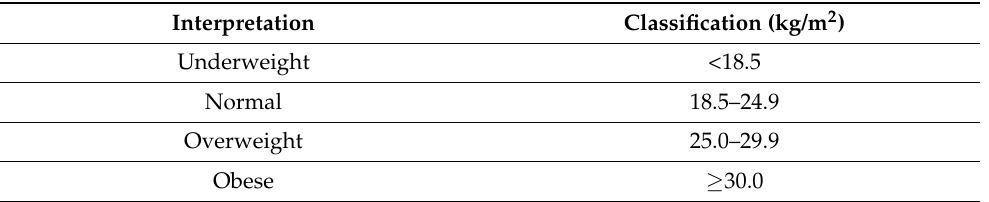
Table 2. Body Mass Index classifications